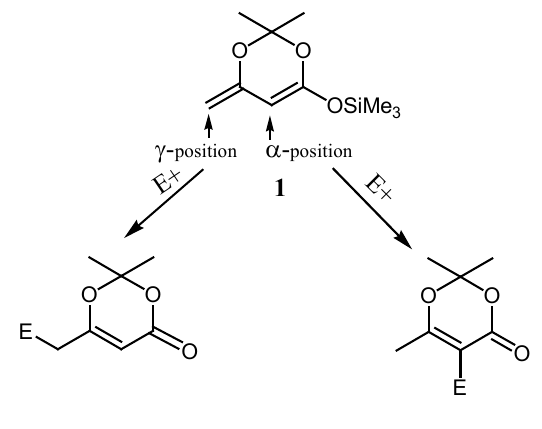
Figure 2. Nucleophilic sites of silyl dienolate 1